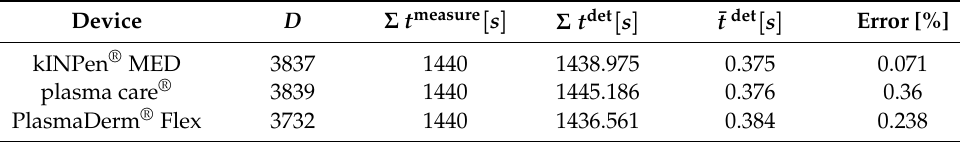
Table 3. Standalone MSD’s average detection time for all plasma source